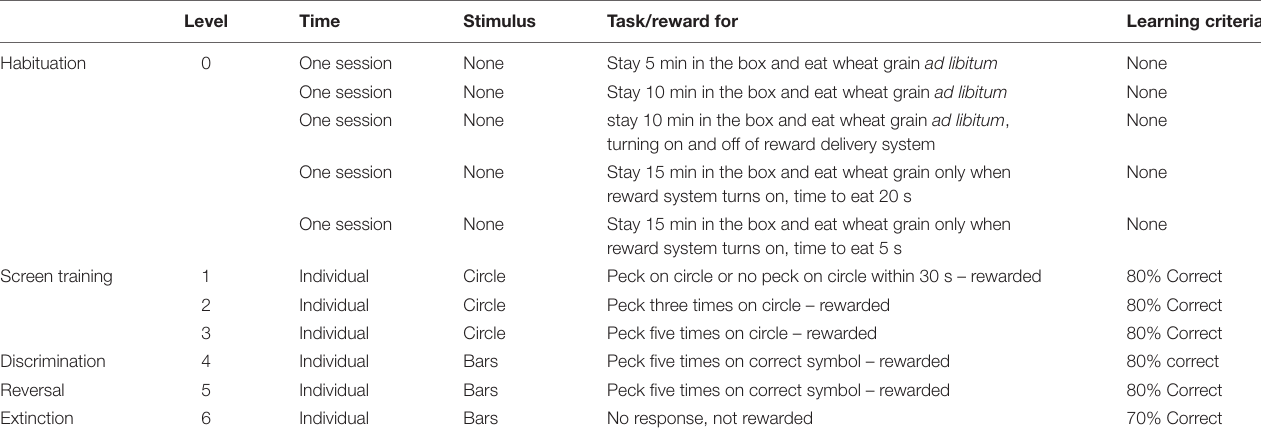
TABLE 1 | Phases of the experiment and their specific